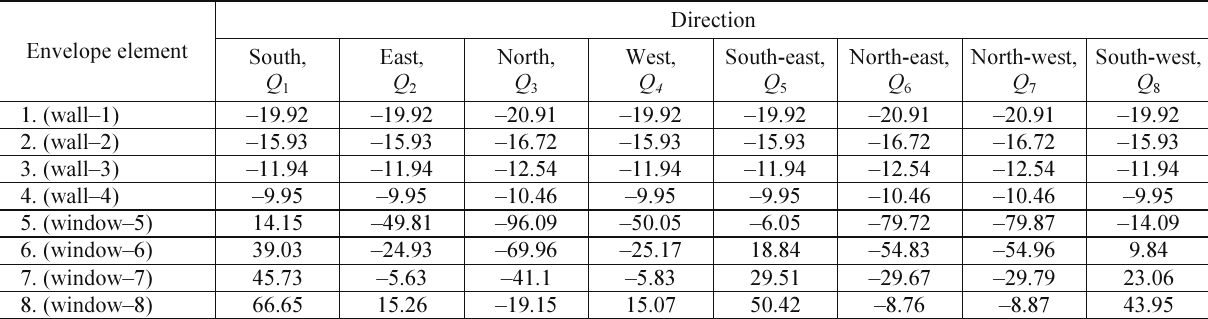
Table 3. Heating season energy balance (kWh) per area of 1m 2 of envelope elements oriented toward various